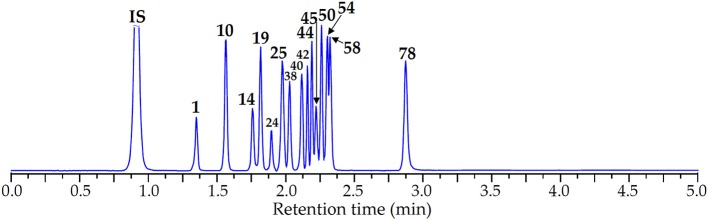
Microcolumn RP-HPLC-DAD chromatogram of the reference mixture of 15 compounds at 280 nm. Compounds are numbered as listed in Table 2. IS, internal standard (scopoletin-7-O-neohesperidoside).